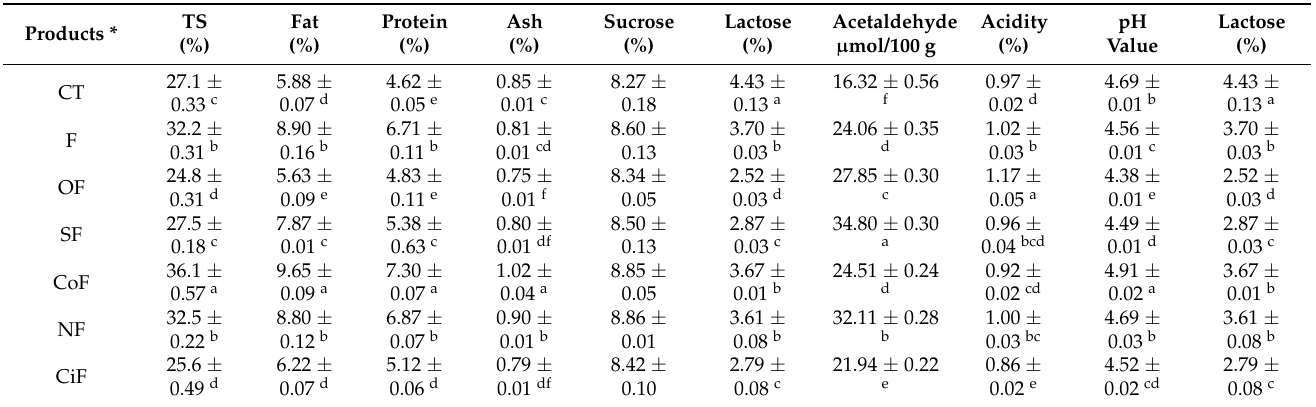
* Refer to materials and methods for details. Data are expressed as Mean ± SE. Different superscripts letters (a, b, c, d, e and f) indicate statistical significance between different treatmnets using chufa milk and the other flavoring materials. Means within the same column with different superscripts differ at p ≤